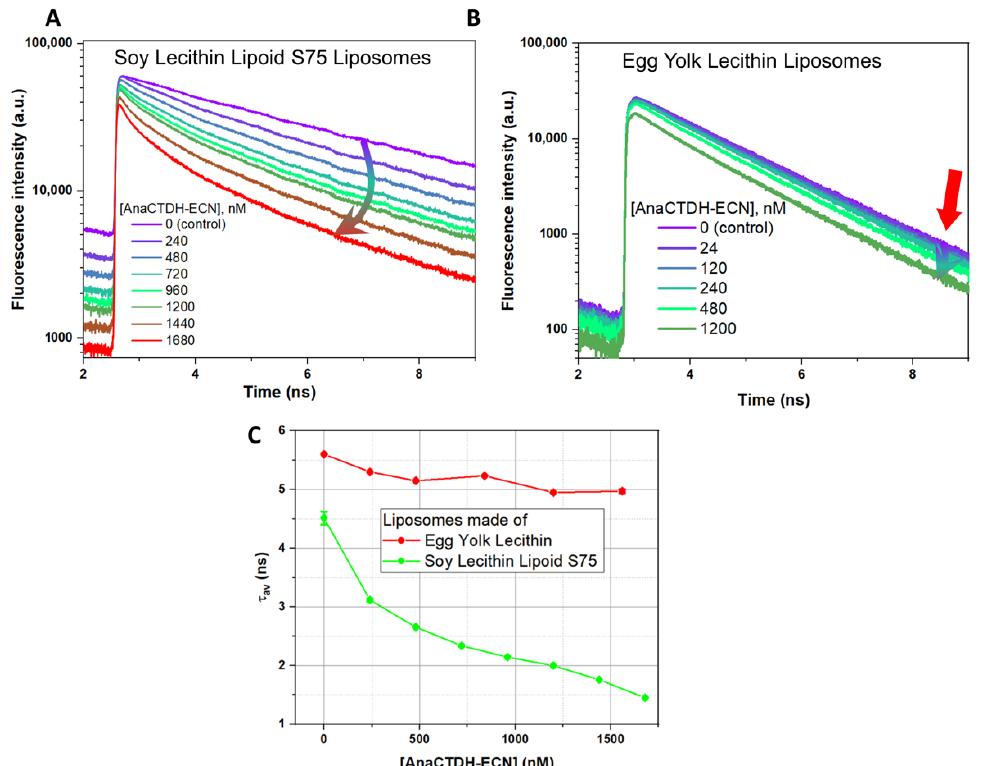
Figure 4. HeteroFRET induced effects between echinenone (ECN, acceptor), delivered by caroteno- protein AnaCTDH into membrane of liposomes, and the fluorescent probe TM-BODIPY (donor, concentration 1 μM) at different concentrations of AnaCTDH-ECN: fluorescence decay curves of TM-BODIPY in ( A ) soy lecithin lipoid S75 liposomes and ( B ) in egg yolk lecithin liposomes (presented in the semi-log scale); ( C ) comparative changes in TM-BODIPY fluorescence average lifetime values τ av . All measurements were performed at 20 °C.